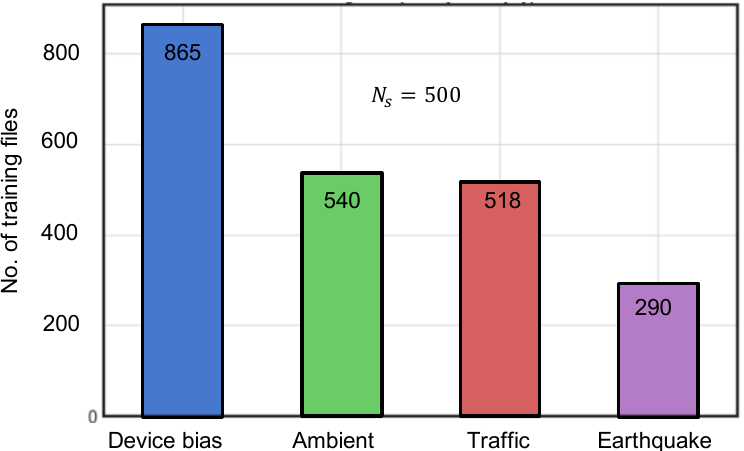
Figure 2. Distribution of vibration categories for training data set.